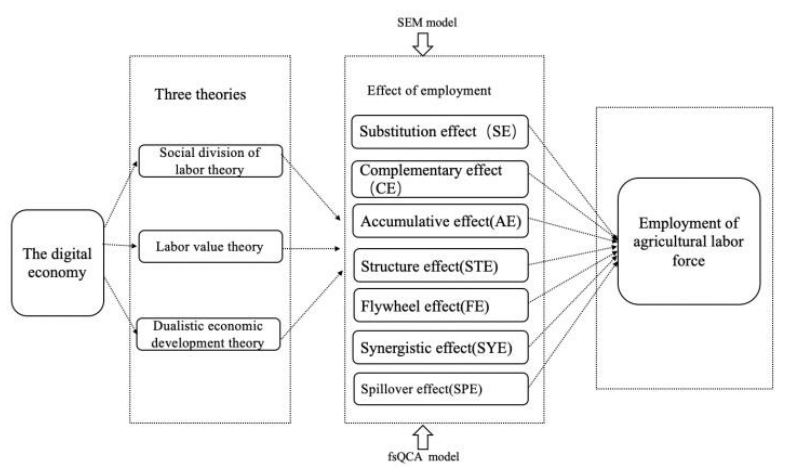
Figure 1. Study framework .